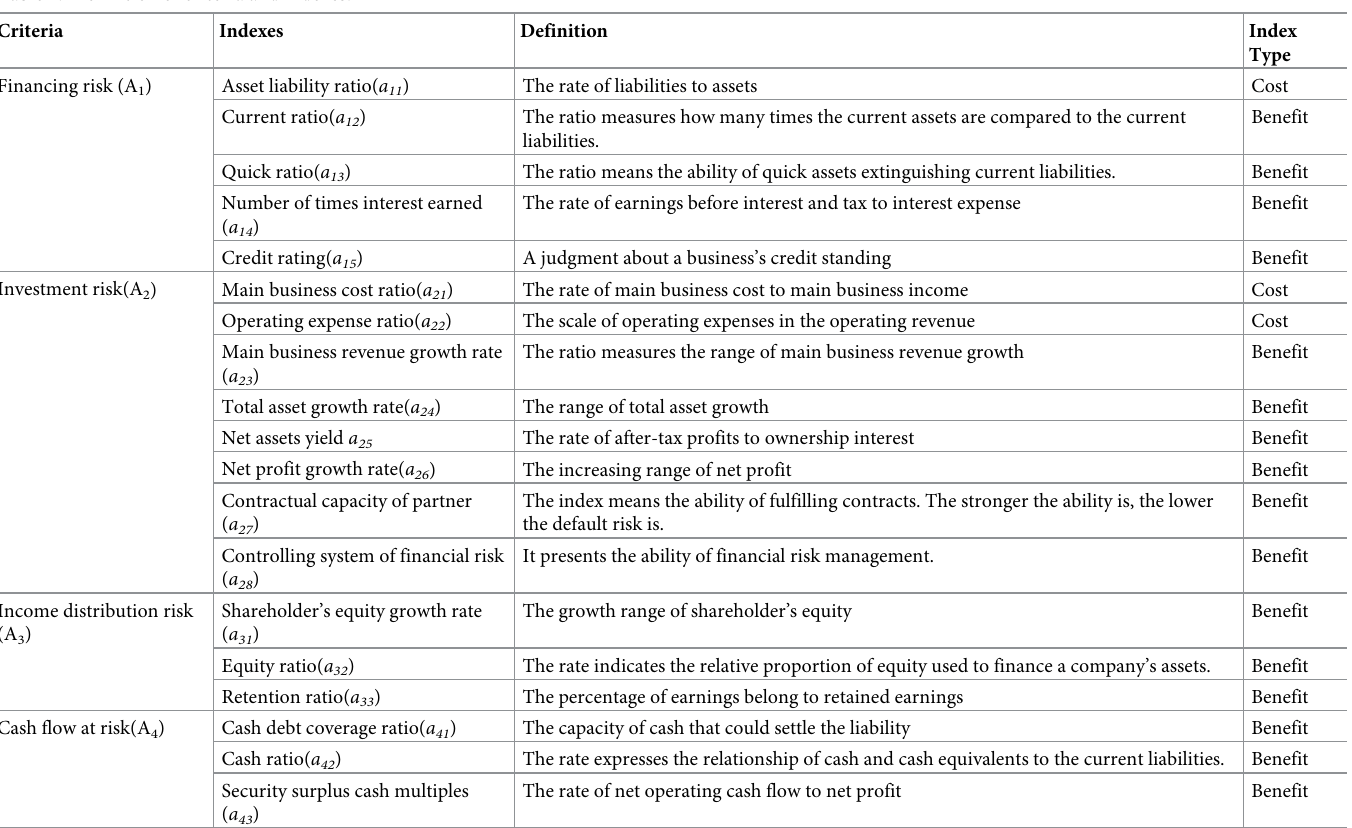
Table 2. Definition of criteria and